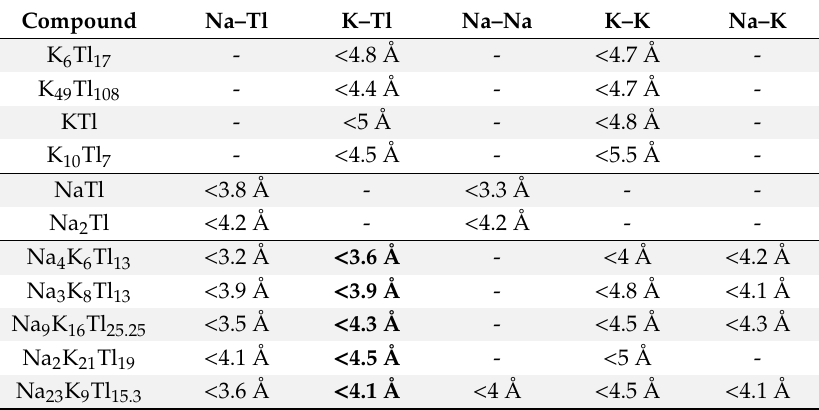
Table 17. The comparison of the distances within the hitherto reported alkali metal thallides which involve sodium and / or potassium suggests that an involvement of sodium results in shorter K–Tl distances